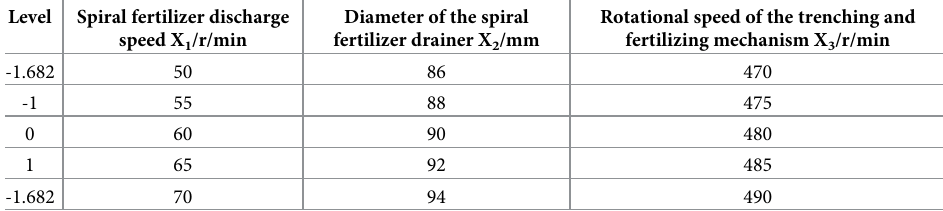
Diameter of the spiral fertilizer drainer X 2